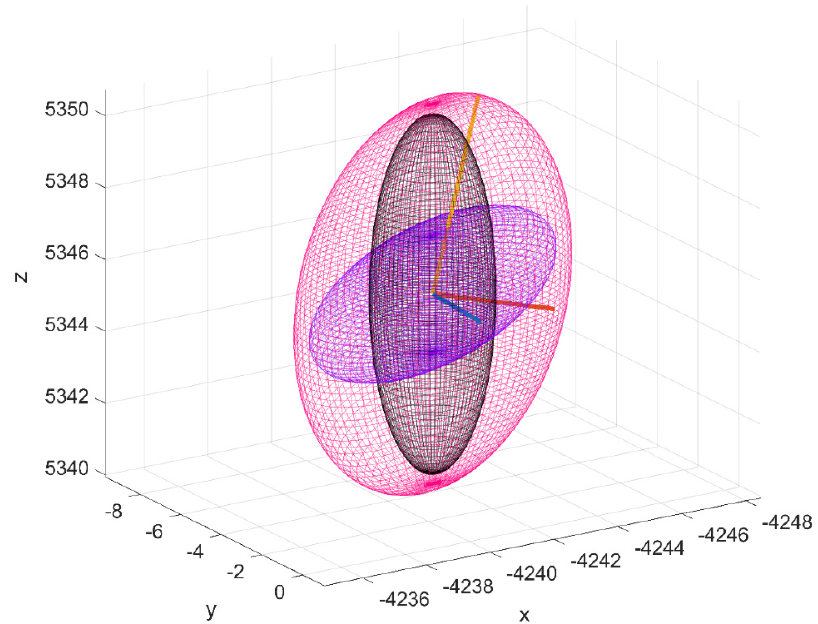
Figure 4. Conceptual illustration of navigation ( purple ) tracking ( black ), total uncertainty volume ( magenta ) and major ( orange ), semi-major ( red ) and minor axis ( blue ) of total uncertainty volume.